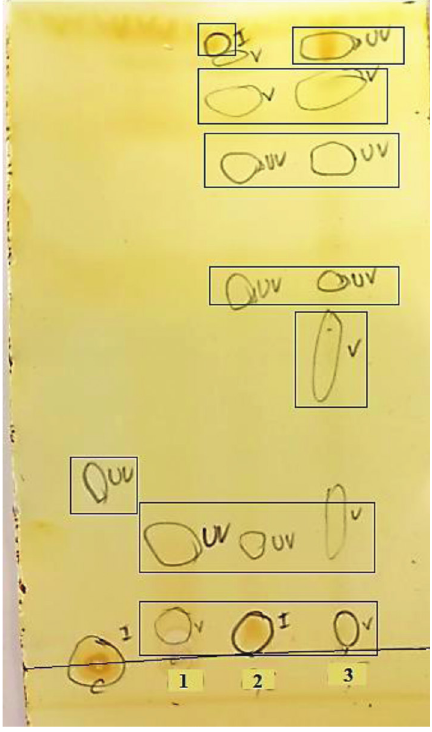
Figure 5: TLC results (C) control, (1) biosurfactant sample of Bacillus safensis , (2) biosurfactant sample of Pseudomonas aeruginosa , (3) biosurfactant sample of Bacillus tequilensis